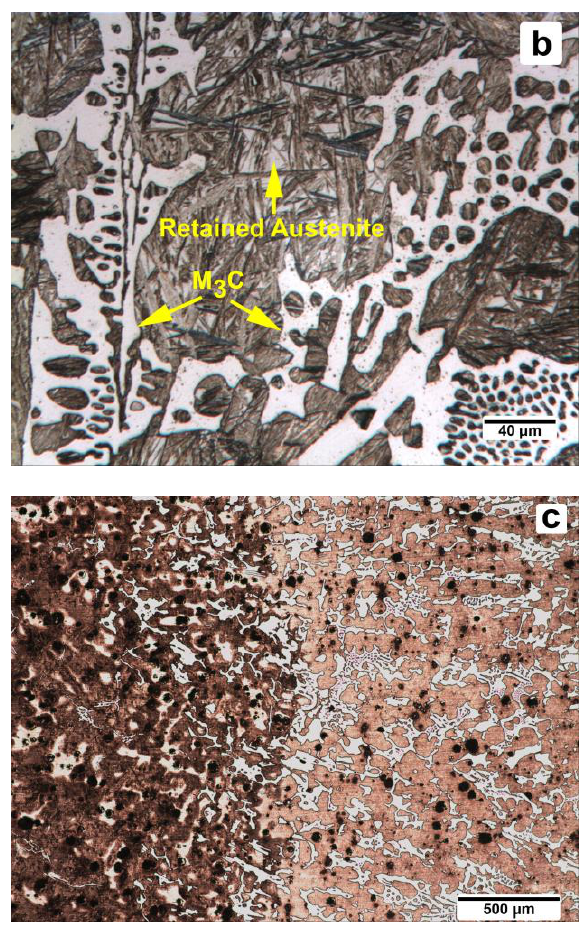
Figure 1. Characteristic microstructure obtained by optical microscopy: ( a ) Experiment 6, Region I of the working layer; ( b ) Experiment 1, Region II of the working layer; and ( c ) Experiment 3, transition zone between the working layer and the core of the roll.